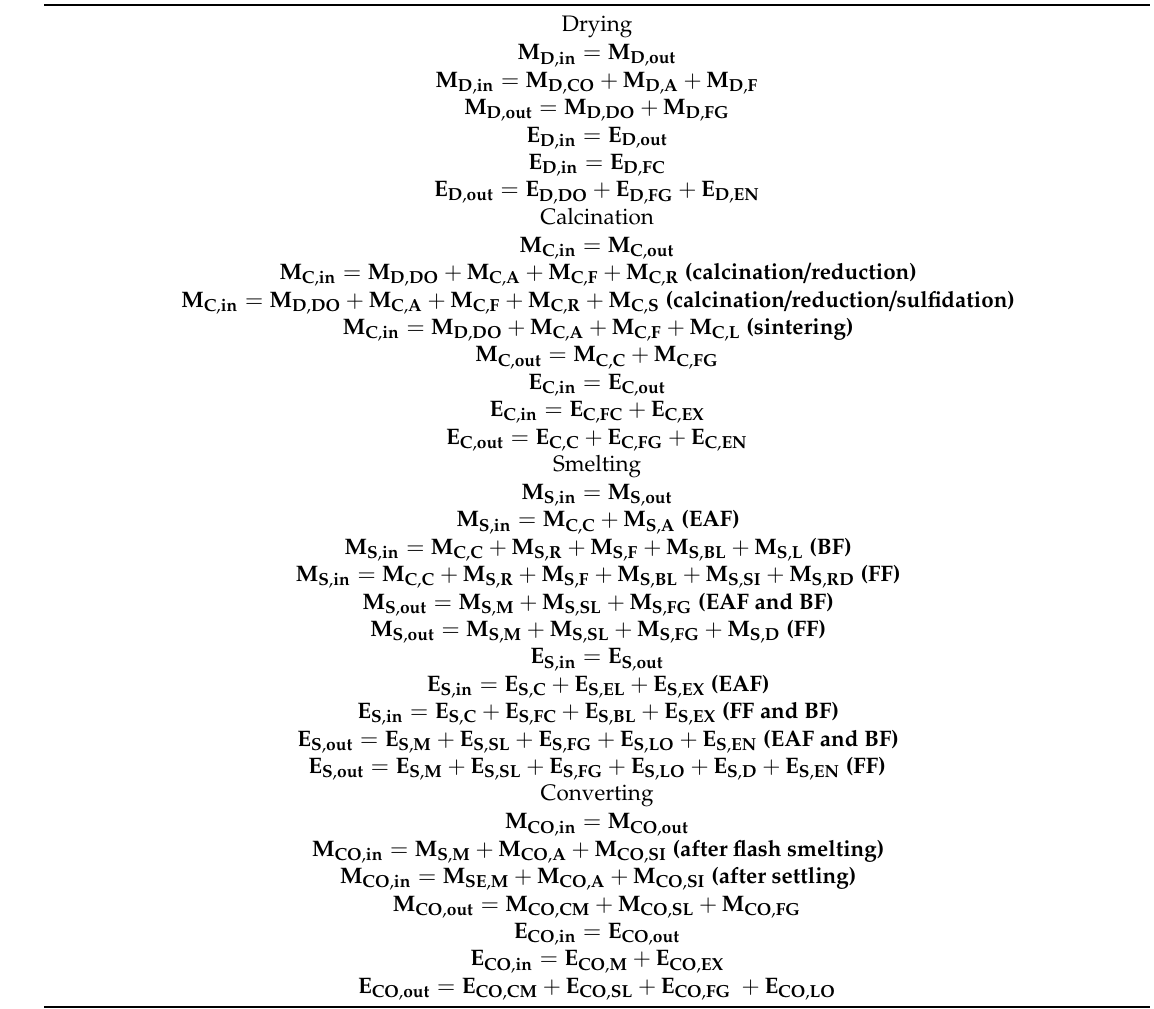
Table A1. Mass and energy conservation in the